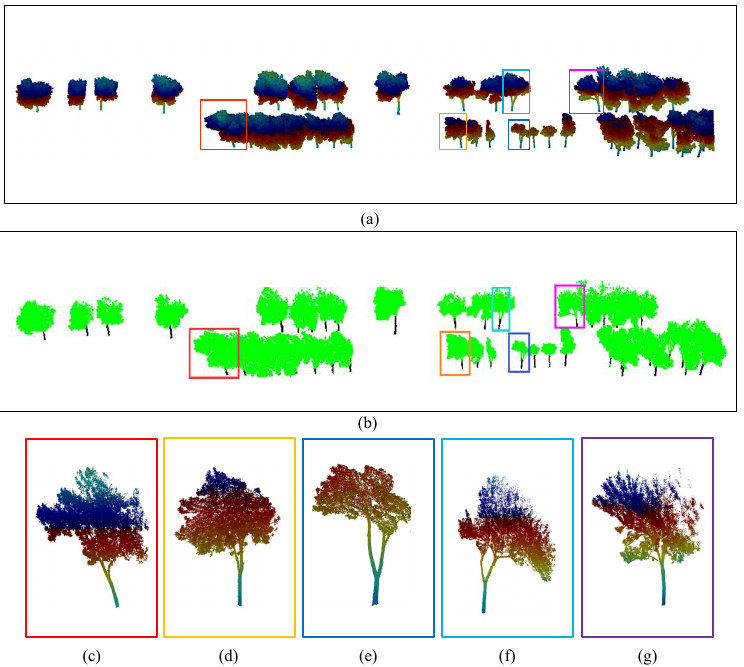
Figure 13. Processing result for dataset 2: ( a ) individual tree segmentation; ( b ) trunk extraction; ( c ) trunk extraction failed (a leaning tree trunk); ( d – g ) incomplete extraction of trunk.